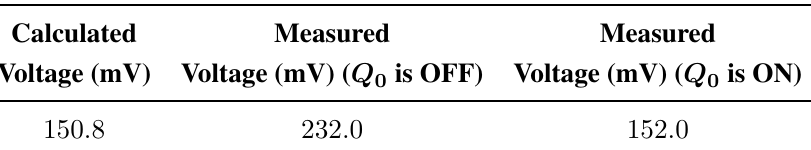
Table 6. U , instrumental amplifier and anti-saturation DS (cid:0) ON